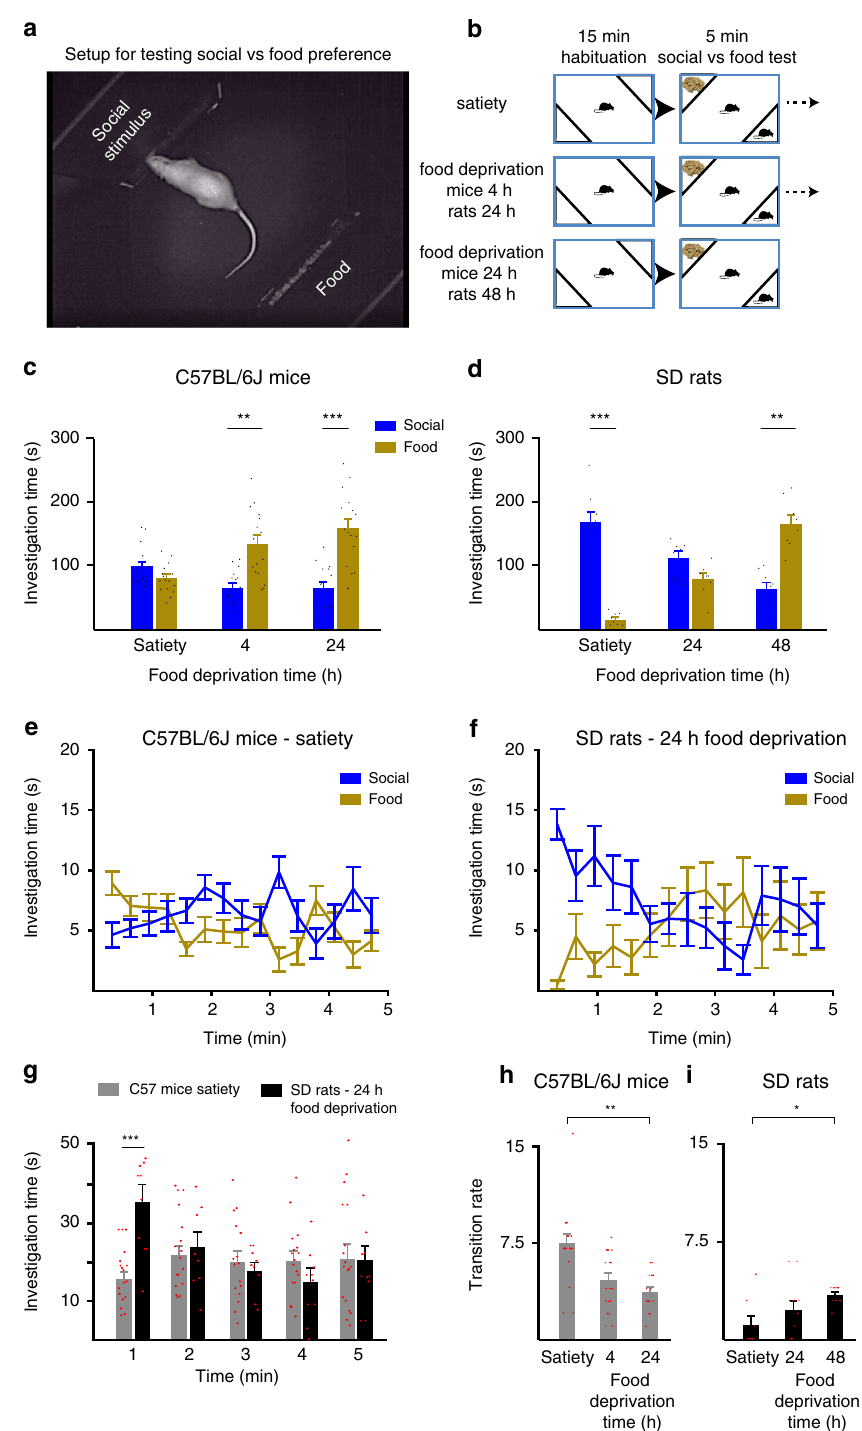
Fig. 7 Differences in social motivation of C57BL/6J mice and SD rats, as revealed by competition between social and food stimuli. a A picture depicting the setup used for creating a competition between social and food stimuli, without allowing the subject to consume the food palettes. b Schematic representation of the experimental timeline, in which the same groups of C57BL/6J mice ( n = 16) and SD rats ( n = 8) were tested following three different conditions of food deprivation, as denoted. c Mean total investigation time (during the 5-min test) of social and food stimuli by mouse subjects, at the three different conditions of food deprivation. d As in c , for rats. e Mean investigation time (20-s bins) of social and food stimuli by mice subjects across time during the test, for satiety condition. f Same as e , for rats following 24 h of food deprivation. g Statistical comparison of mean social investigation time (1-min bins) across time during the test, between SD rats and C57BL/6J mice at conditions were no general preference was exhibited. h Mean transition rate for the fi rst minute of the test for the experiments shown in ( c ). i As in h , for the experiments shown in ( d ). * p < 0.05, ** p < 0.01, *** p < 0.001, post hoc two-tail t test following the main effect. All error bars represent SEM. Source data are provided as a Source Data fi